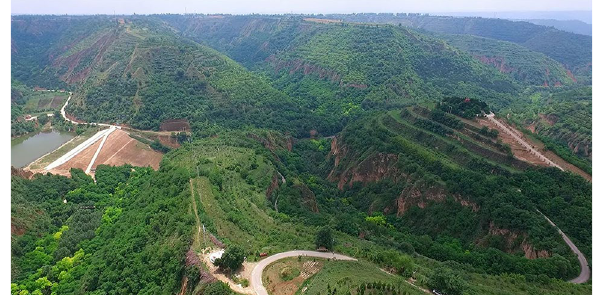
Figure 1. Effects of soil and water conservation on the Loess